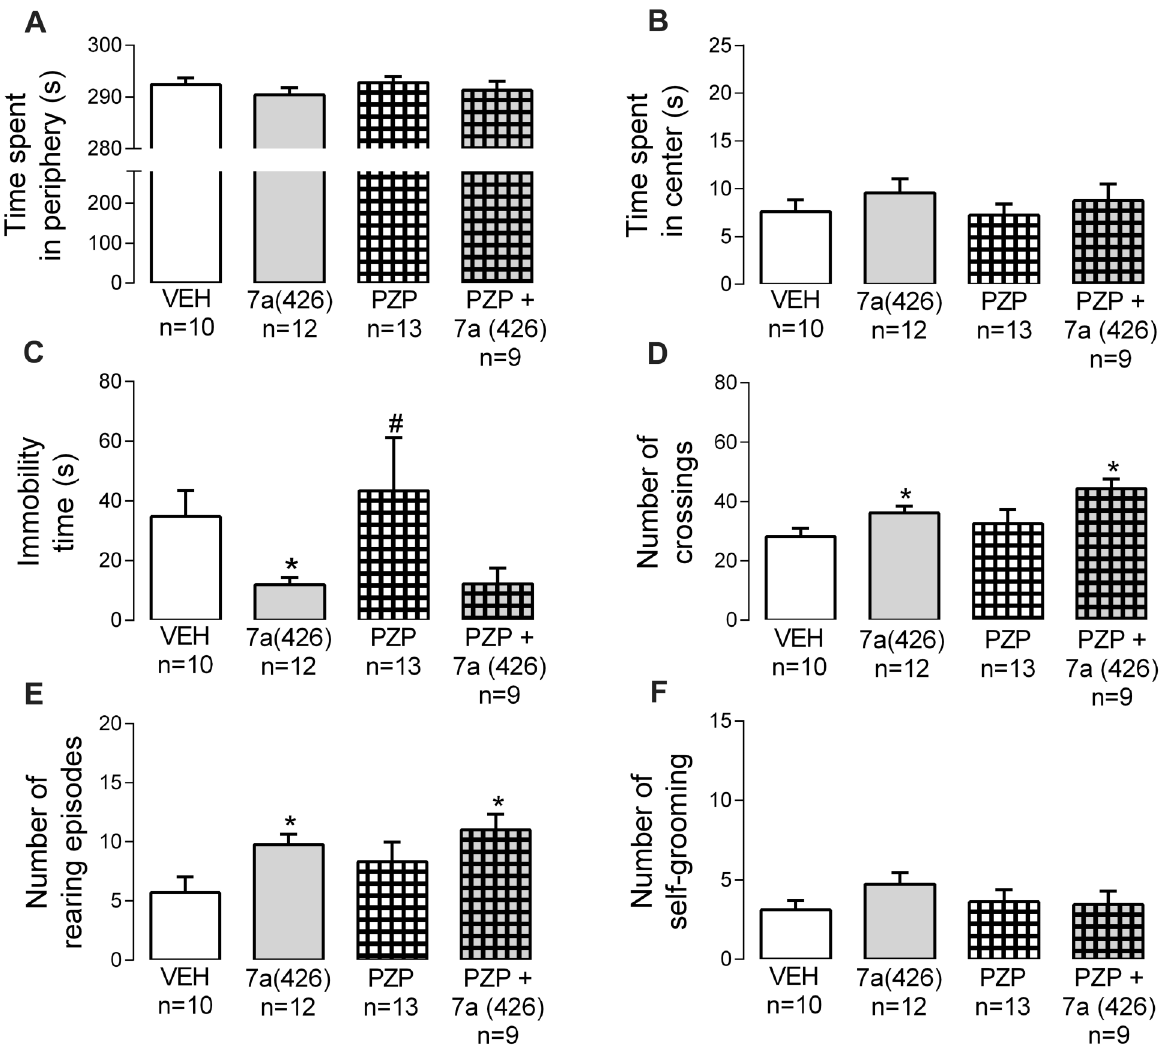
Figure 4. Contribution of muscarinic receptor subtype 1 (as revealed by the antagonism with pirenzepine) to the effects evoked Bj-PRO- 7a on locomotion/exploration in the open fi eld. A , Time spent in periphery; B , Time spent in center; C , Immobility time; D , Number of crossings; E , Number of rearing episodes; F , Number of self-grooming episodes. Experimental groups: VEH: vehicle (0.9% NaCl); 7a (426): Bj-PRO-7a (426 nmol/kg); PZP: pirenzepine (852 nmol/kg); PZP + 7a (426): co-administration of PZP and Bj-PRO-7a (426 nmol/ kg). Data are reported as means ± SE. *P o 0.05 vs vehicle; # P o 0.05 vs 7a (426) (one-way analysis of variance followed by Fisher ’ s post hoc